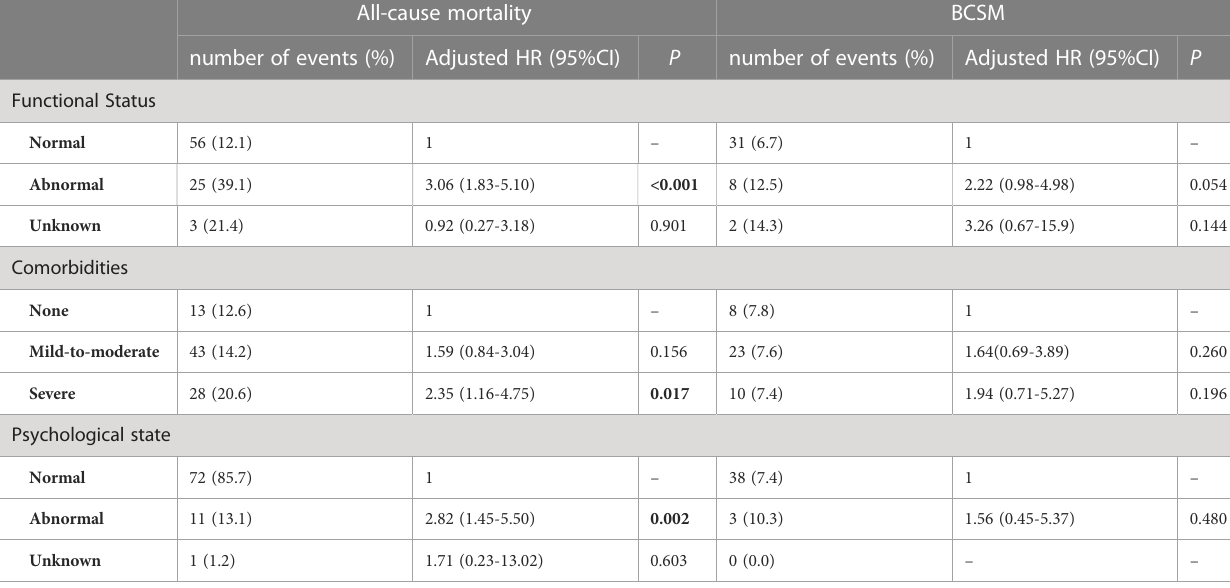
TABLE 2 Adjusted HRs for all-cause mortality and BCSM based on geriatric assessment domains. All-cause